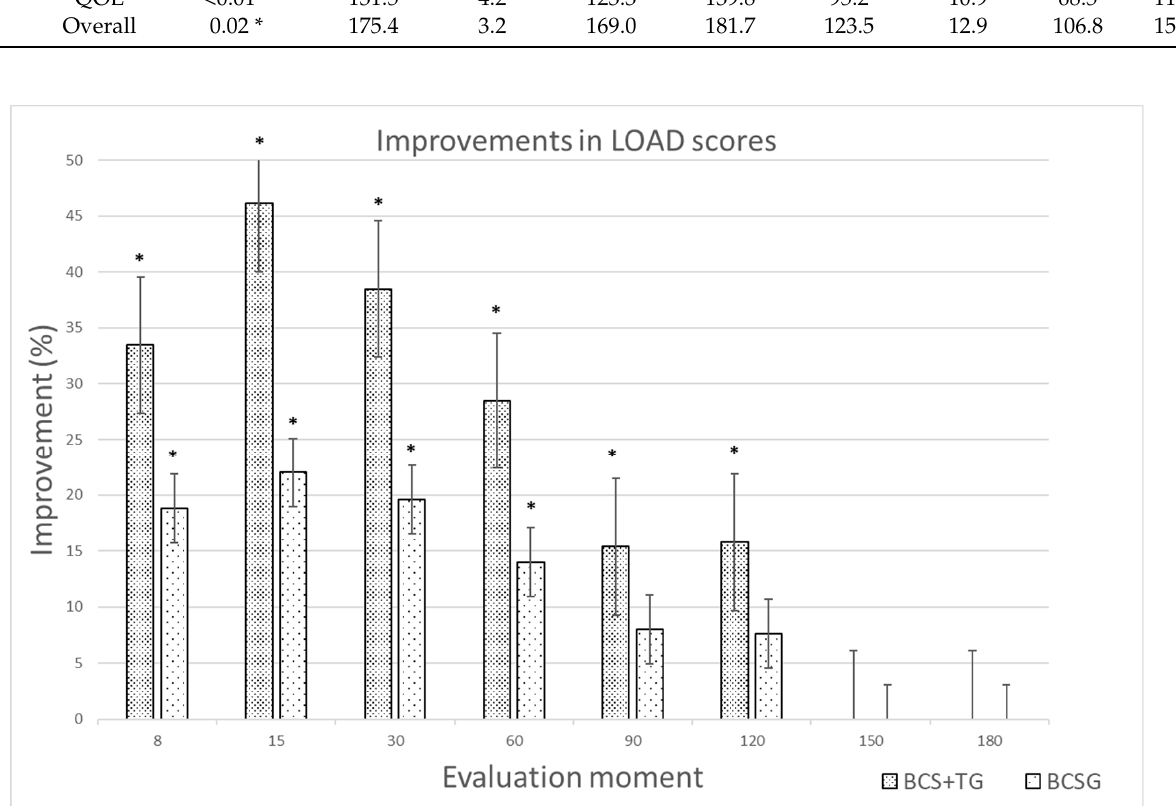
Figure 3. Improvements (%) in Liverpool Osteoarthritis in Dogs (LOAD) scores for the Blood Cell Secretome + triamcinolone group (BCS+TG) and the Blood Cell Secretome group (BCSG), compared to baseline values. * indicates a clinically significant improvement (reduction ≥ 4).